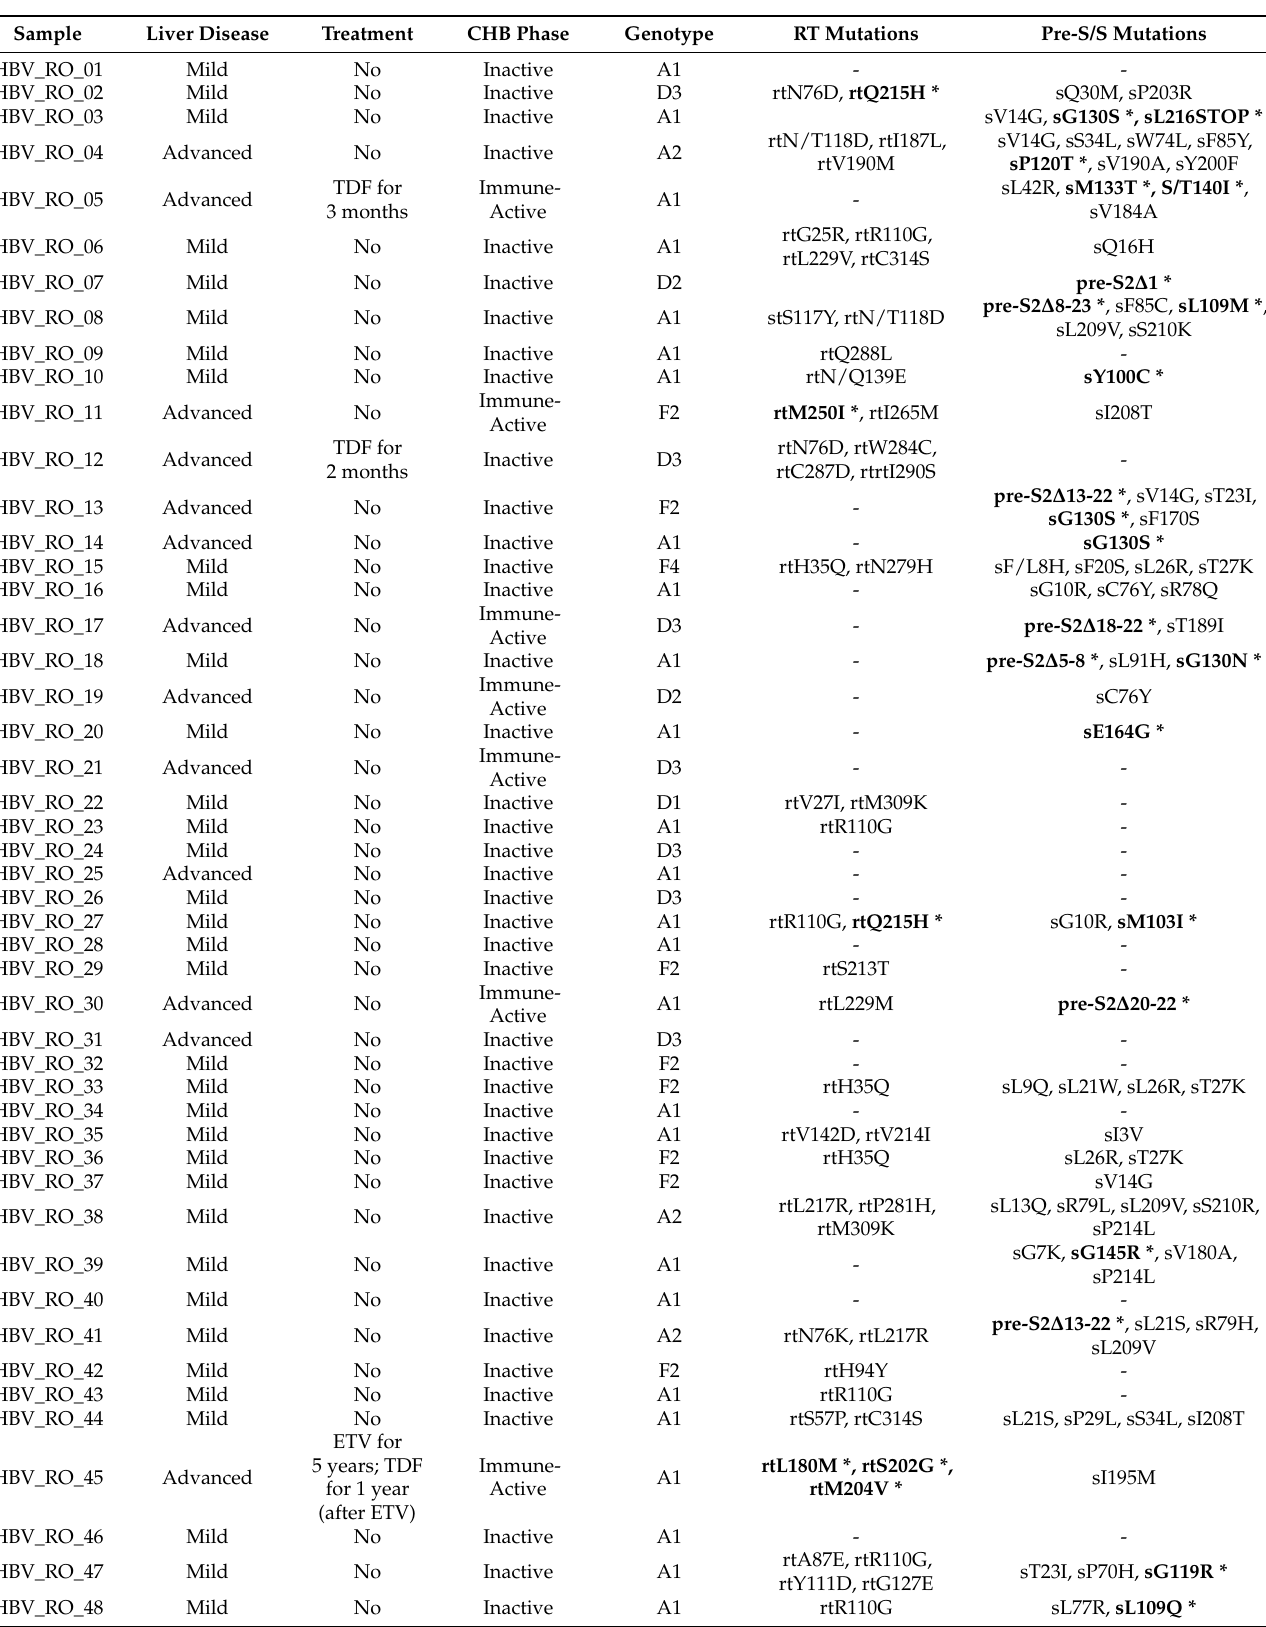
Table 2. Characteristics of samples with clinically relevant